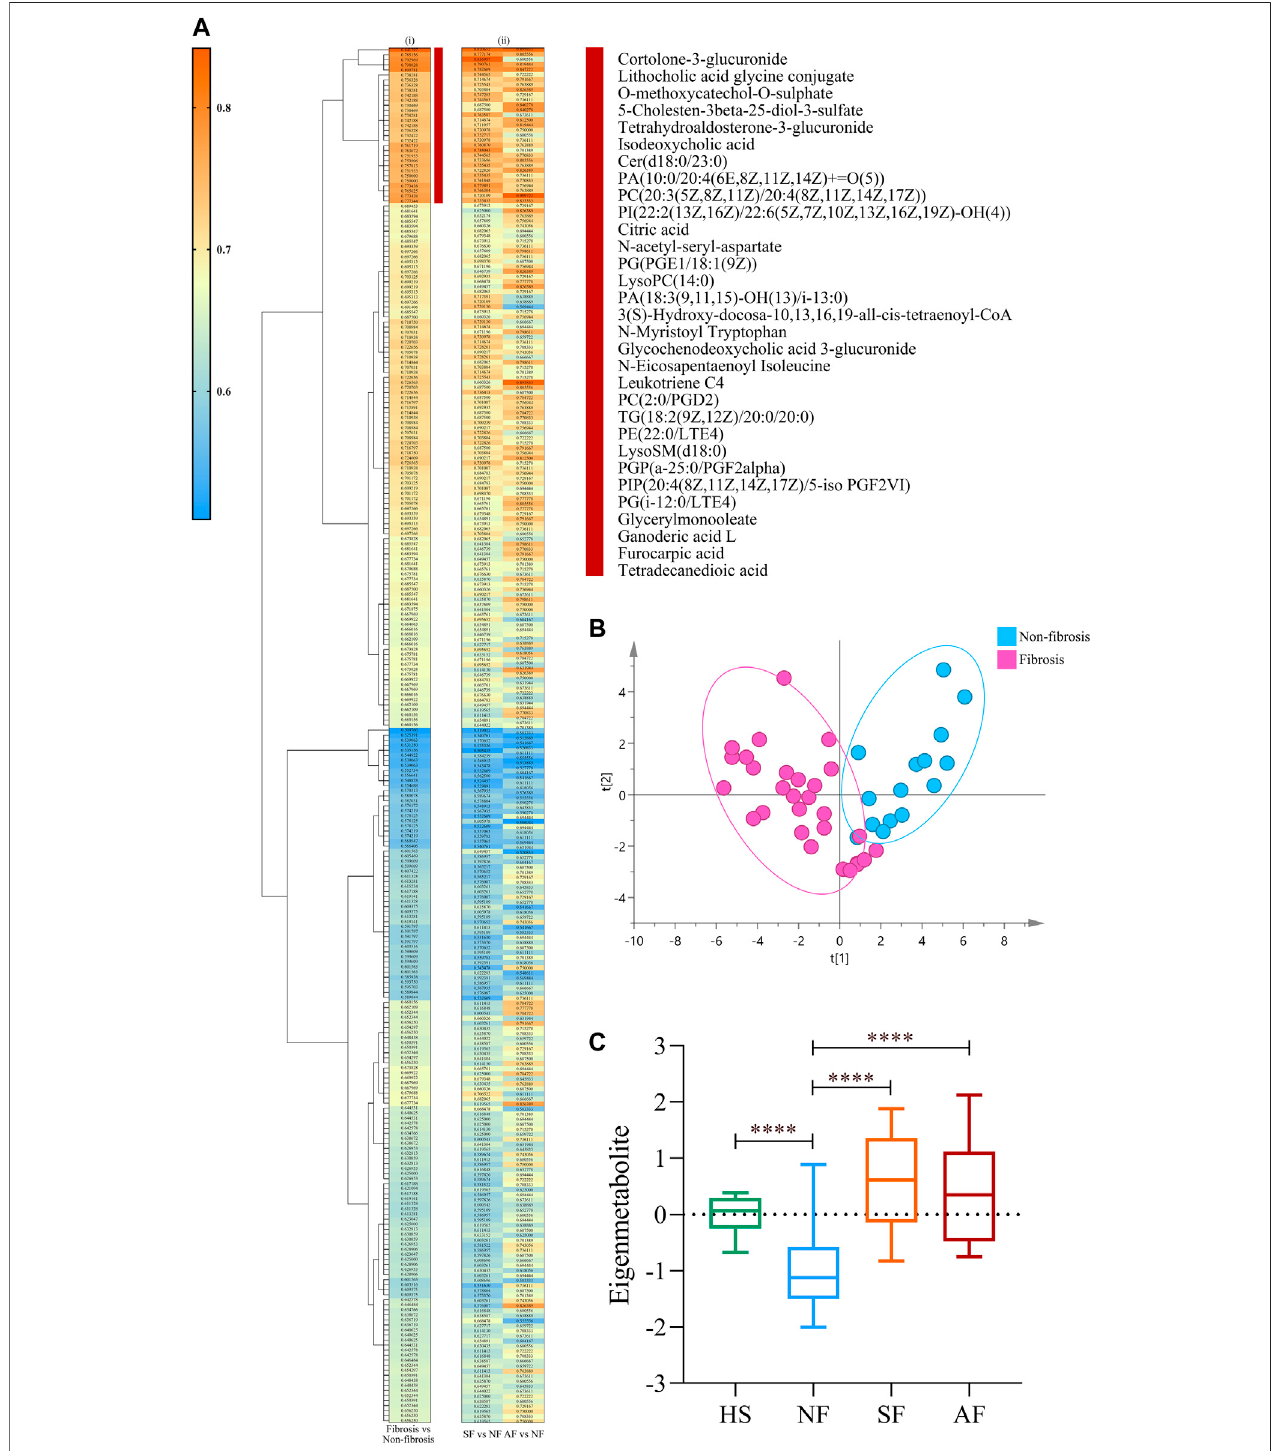
FIGURE 2 | Identi fi cation of fi brosis-related metabolite fi ngerprint. (Ai) Hierarchical cluster analysis of the area under the receiver operating characteristic curve (AUC)and p -valuedifferentiationbetween fi brosis(SF+AF)andnonsigni fi cant fi brosisgroups.Verticalbrownish-redbaridenti fi edthe31-metabolitecluster,whichacted as the fi brosis-associated metabolite fi ngerprint. (Aii) Corresponding metabolite AUC and p -value in accessing the SF or AF groups relative to fi brosis. (B) Principal component analysis of the fi brosis metabolite fi ngerprint between fi brosis and nonsigni fi cant fi brosis DILI patients. (C) Change of the fi brosis eigenmetabolite in patients with different stages of fi brosis progression. Data are presented as mean ± SD. **** p < 0.0001, compared with the NF group. HS, healthy subjects; NF, nonsigni fi cant fi brosis; SF, signi fi cant fi brosis; AF, advanced fi brosis.